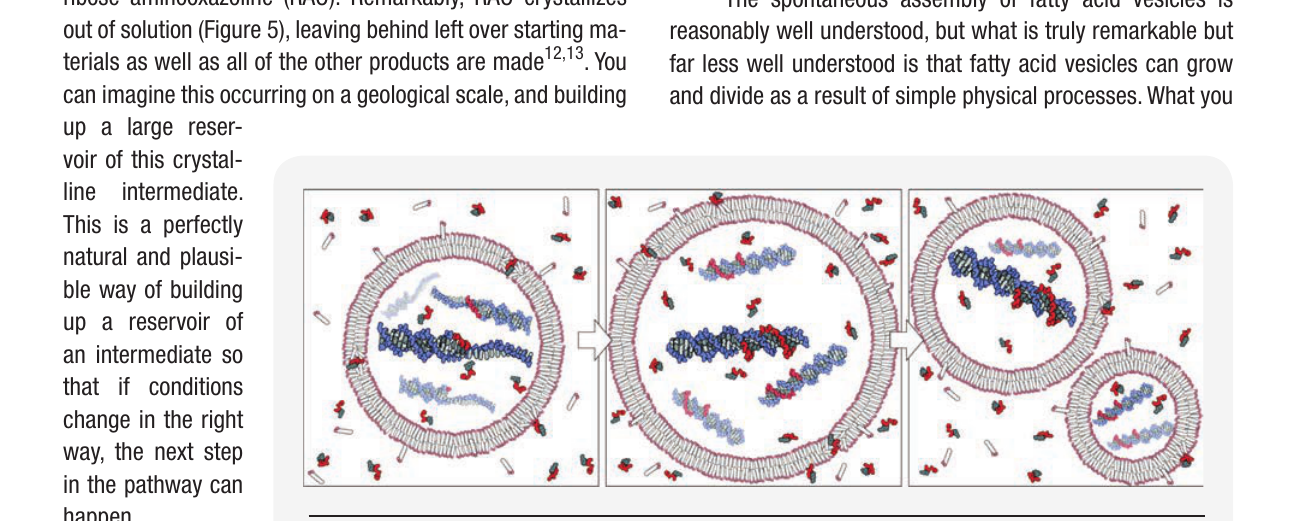
Figure 6. Schematic model of a protocell. A simple cell might be based on a replicating vesicle for compartmentalization, and a replicating genome to encode heritable information. A complex environment provides nucleotides, lipids and various sources of energy. Mechanical energy (for division), chemical energy (for nucleotide activation), phase transfer and osmotic gradient energy (for growth) may be used by the system. From Mansy et al., Nature,